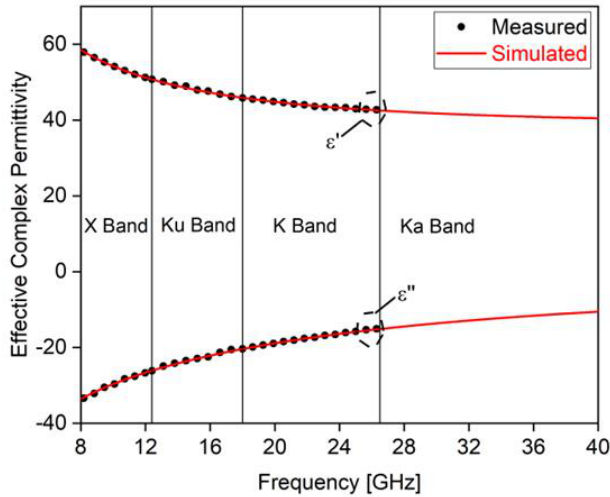
Figure 16. Real and imaginary parts of the complex permittivity of the graphene-based paint from X to K bands and the simulated trend obtained by the Debye’s formula up to 40 GHz.